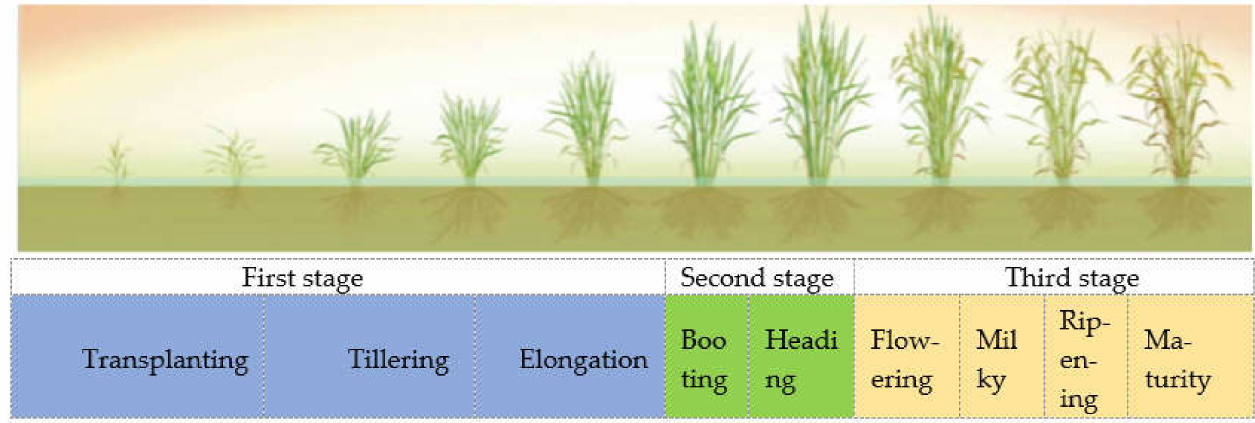
Figure 7. Phenological growth characteristics of paddy.